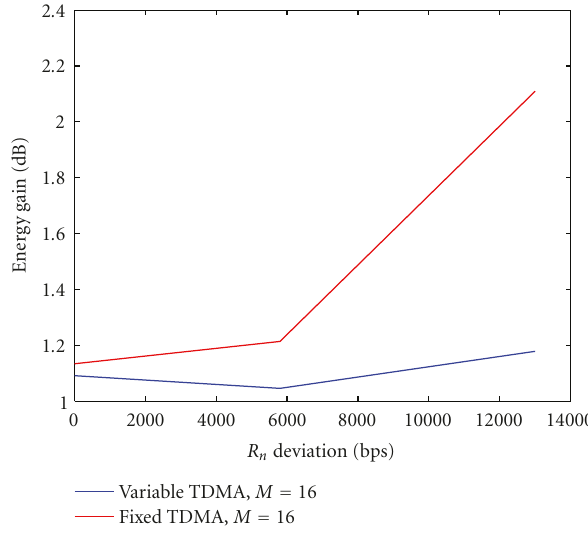
Figure 5: Energy gain with respect to fixed TDMA and variable length TDMA with 16-QAM modulation, N = 64 symbol periods.